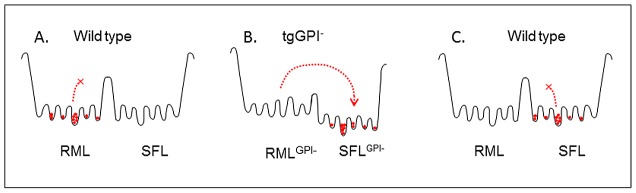
Conjectural free energy profile.(A) The RML quasi-species in wild-type brain are confined to a set of wells separated from those of the SFL quasi-species by a high activation energy barrier. (B) In tgGPI− brain the transition to the “SFLGPI-” set of conformations is enabled by a lower activation energy barrier. (C) SFLGPI- prions introduced into wild-type brain can now occupy, and are trapped in, the set of “SFL wells” which was not accessible to RML prions in (A).